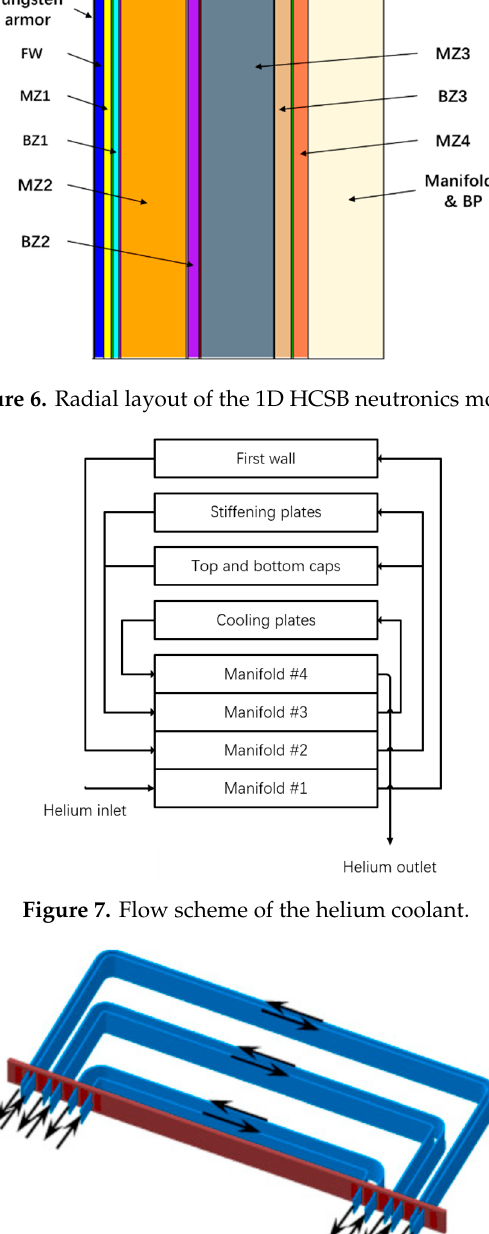
Figure 7. Flow scheme of the helium coolant.